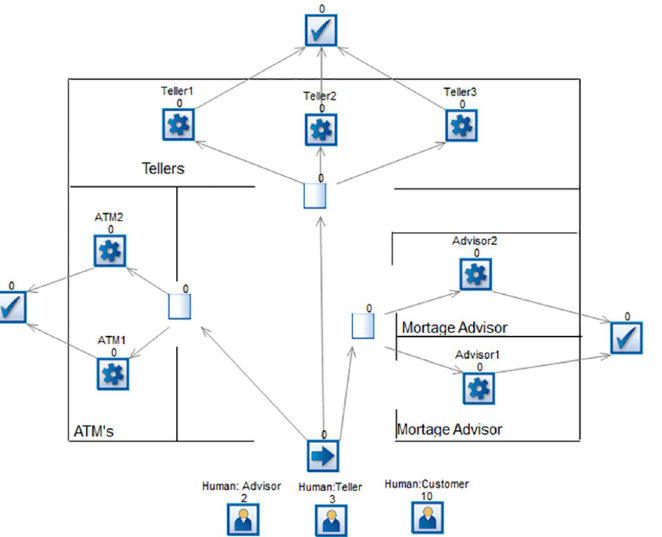
Fig 7. Simul8 model showing bank activities.